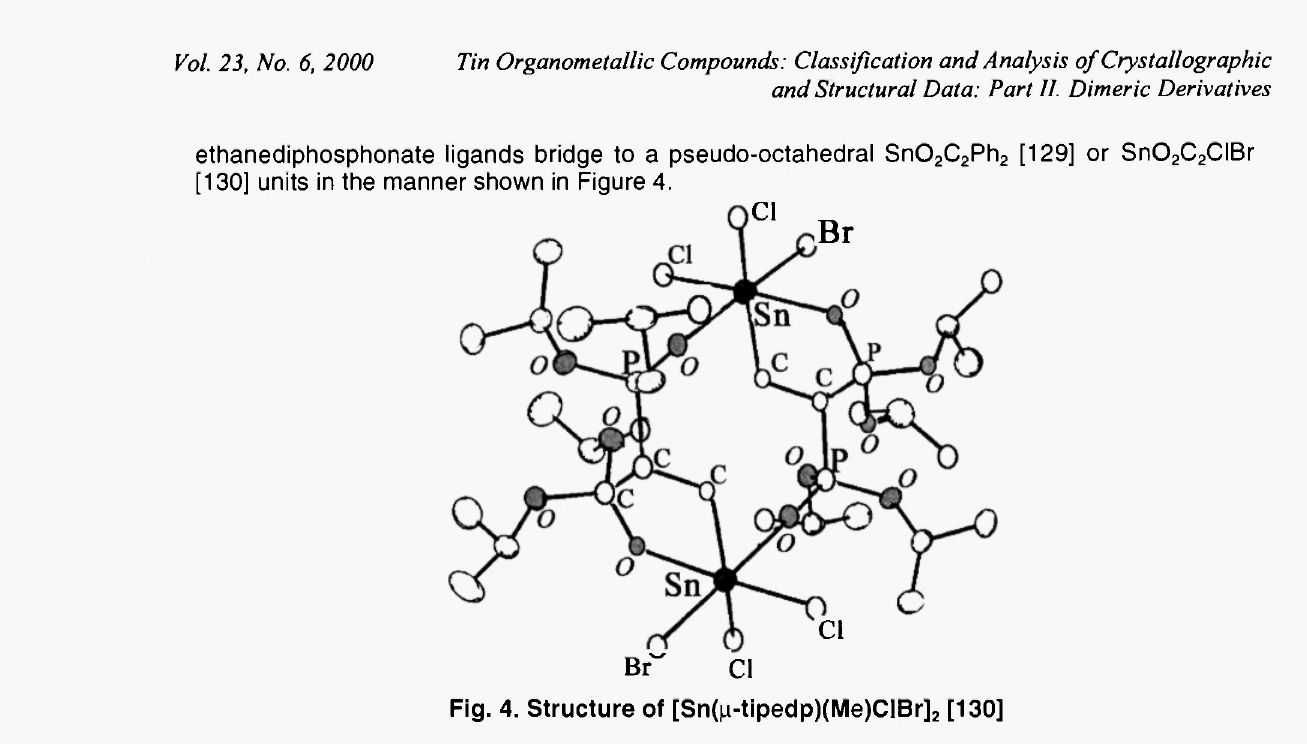
Fig. 4. Structure of [Sn^-tipedp)(Me)CIBr] 2